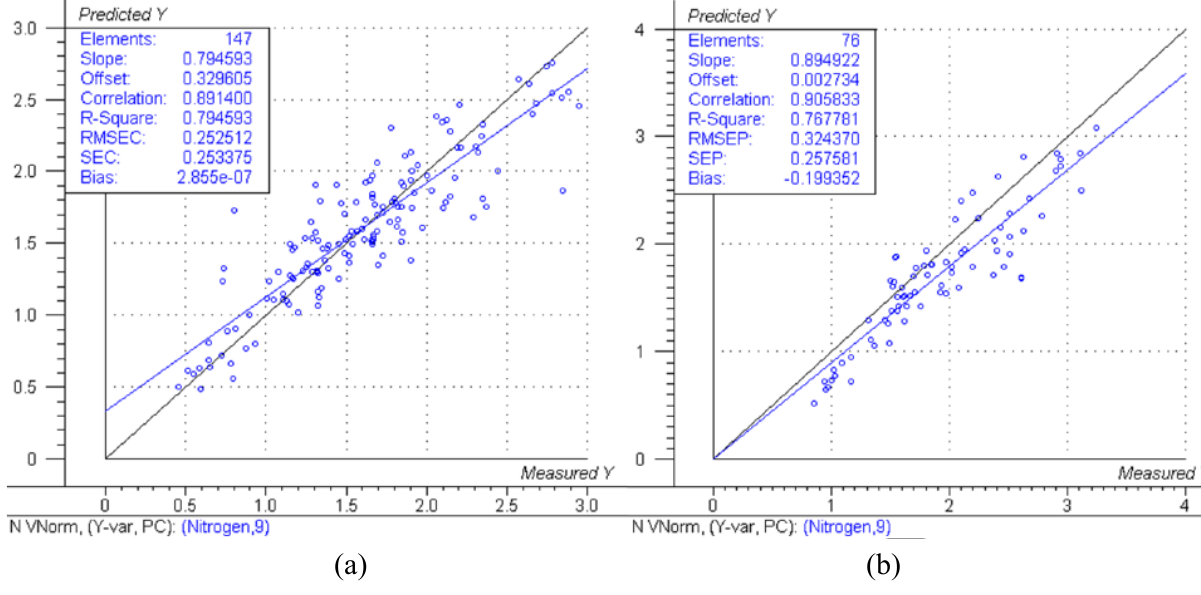
Figure 1. Predicted vs. reference plots and model data for: (a) Nitrogen calibration. ( b ) Nitrogen validation. The black lines represent the ideal 1:1 relationship between reference and predicted measurements, the blue lines represent the actual regression lines calculated in each calibration or validation.